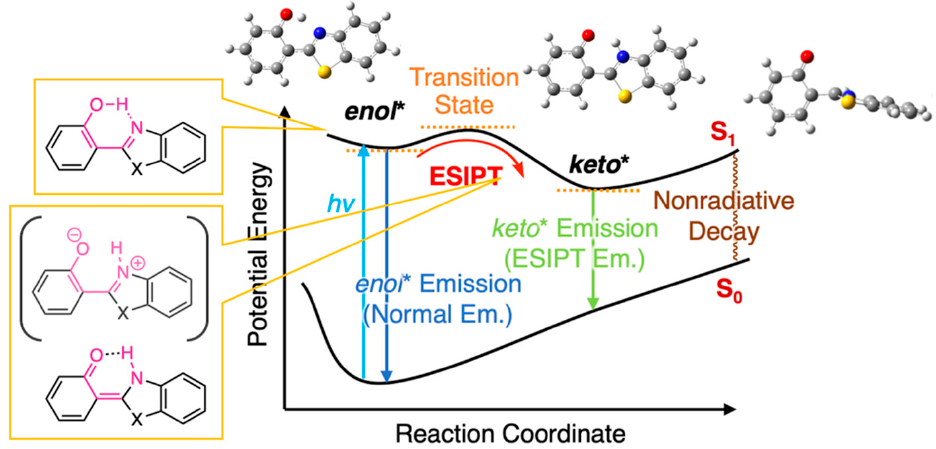
Figure 1. Schematic illustration of potential energy diagram of ESIPT process in 2-(2-hydroxy- phenyl)benzazole.